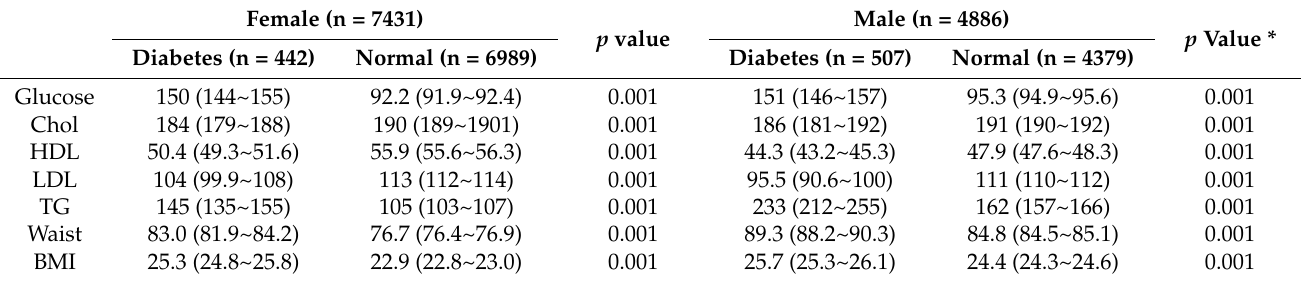
Table 2. Adjusted mean ¶ and 95% CI of serum glucose concentration, lipid profiles, and BMI according to genders and diabetic condition after adjustments for covariates.